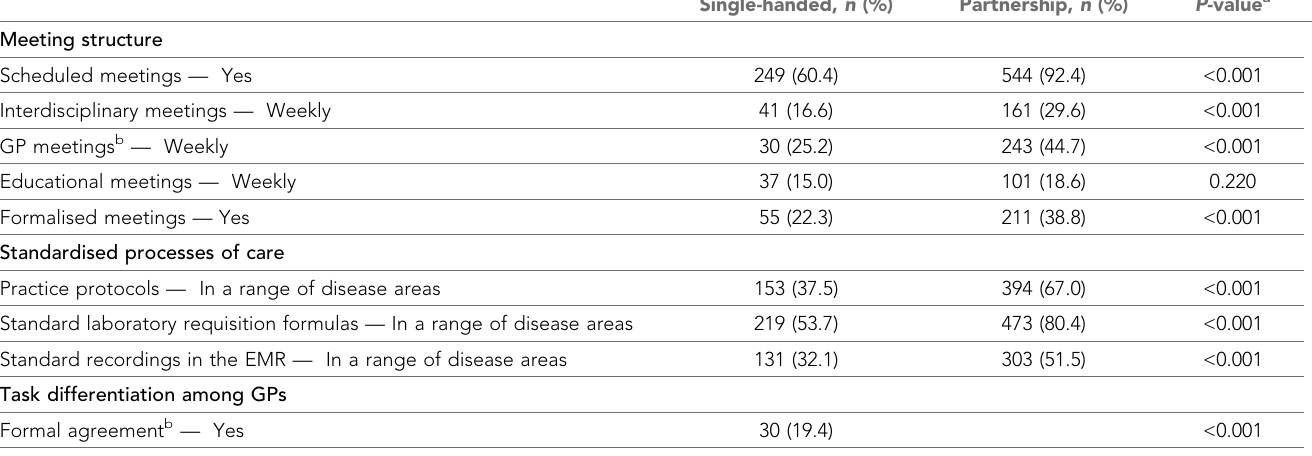
Table 1. Distribution of implementation activities in single-handed and partnership